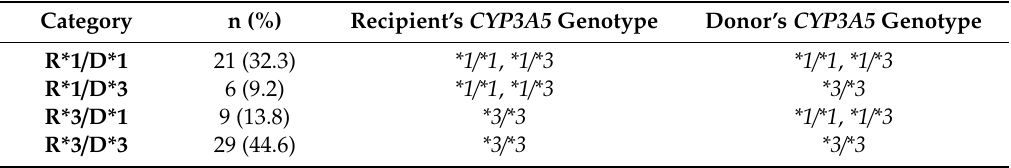
Table 2. Classification of the patients by the combination of the recipient’s and donor’s CYP3A5 polymorphisms.